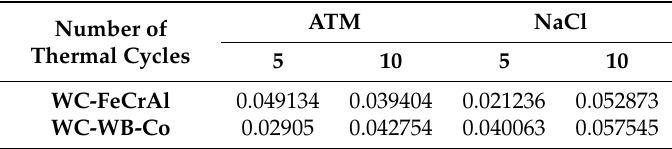
Figure 15. Pins after sliding wear test of the WC ‐ WB ‐ Co in dry atmosphere (ATM) and in sodium chloride (NaCl) solution. Table 7. Wear of the balls (mm 3 ).